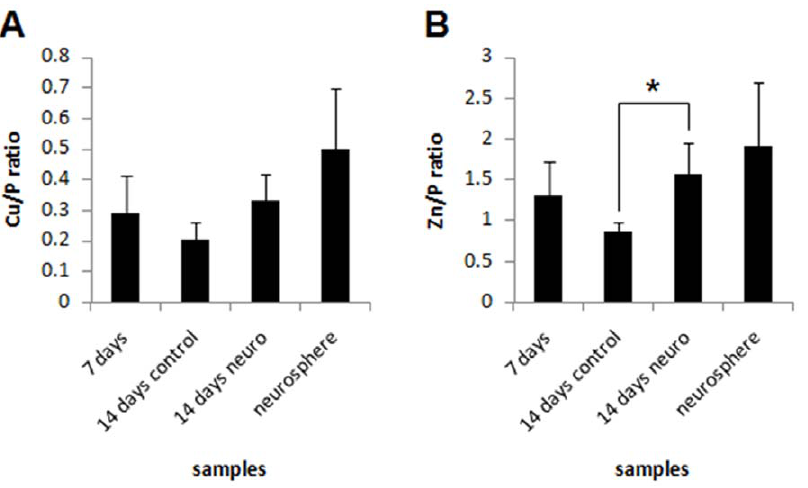
Figure 12. Human embryoid bodies and neurospheres present comparable amounts of metallic elements. Embryoid bodies and neurospheres metals were normalized by phosphorus content. A) Cu/P ratio; B) Zn/P ratio. *p , 0.05.